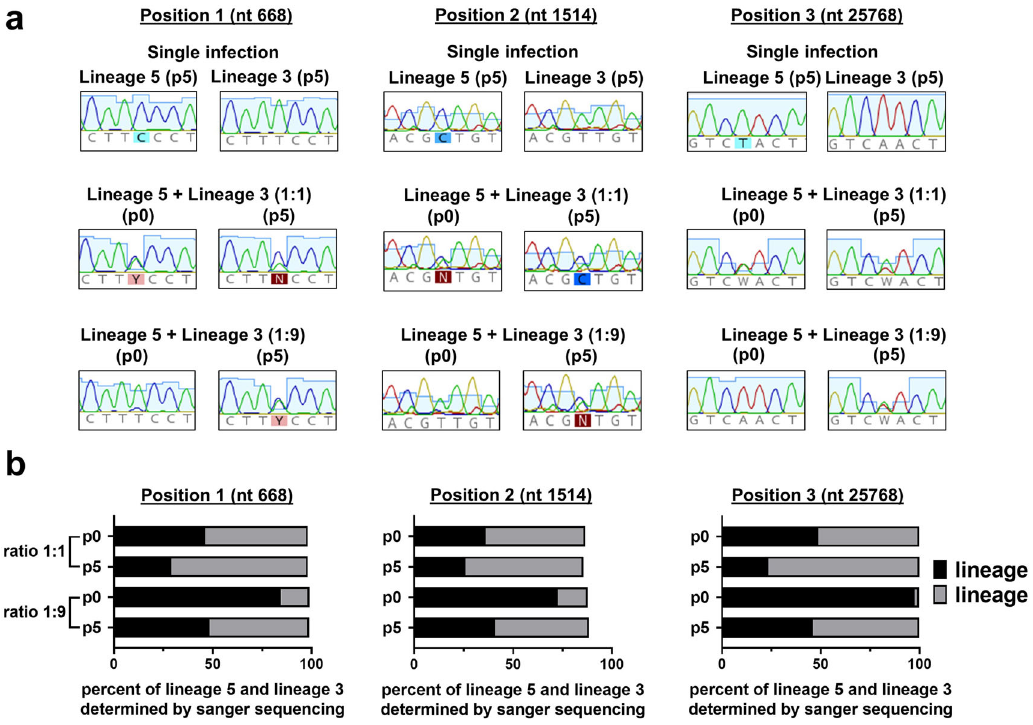
Fig. 3 Lineage 5 outcompetes a parental virus strain of lineage 3 in an in vitro fi tness competition assay. Calu-3 cells were infected in duplicates with 10,000 PFU containing the indicated ratios of a lineage 3: lineage 5 virus isolate at the time of initial infection (p0). Ca 1,000 – 10,000 PFU were transferred in fi ve subsequent passages. a At p0 and p5, viral RNA was isolated from the inoculum/supernatant and two RT-PCRs covering two SNP that discriminate lineage 3 and lineage 5 were performed. RT-PCR amplicons were subjected to Sanger sequencing to visualize shifts in sequence composition. Data of one representative experiment is shown b the average peak heights in sequencing chromatograms at each SNP were analyzed using the ChromatQuantitator server and compared between p0 and p5 populations. nt, nucleotide; p,